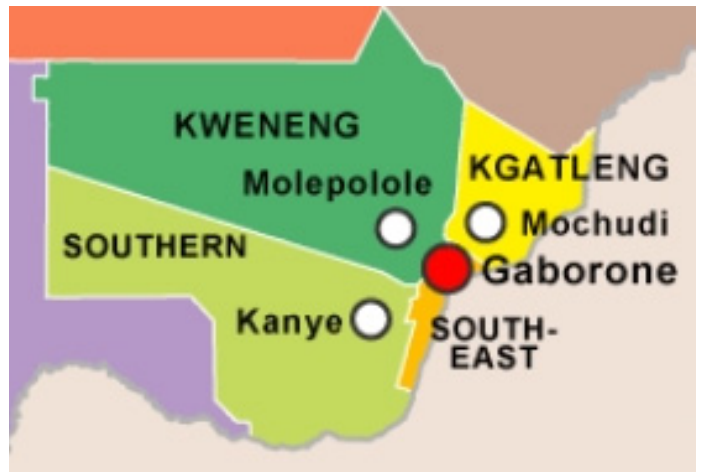
Figure 2. Map showing geographical location of Districts selected for the study (http://mapsopensource.com/botswana-districts-map.html, accessed 21 March 2022).